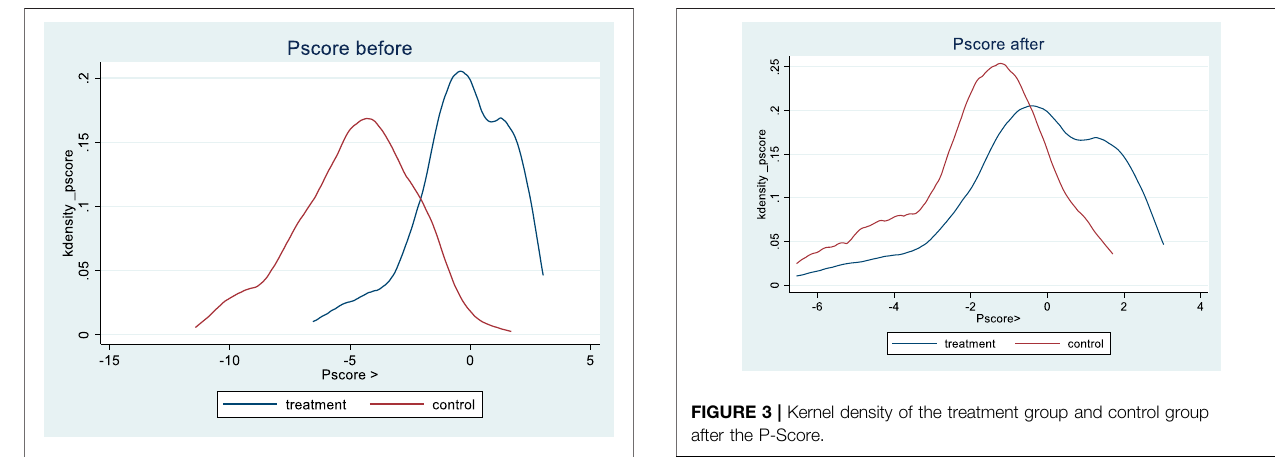
FIGURE 2 | Kernel density of the treatment group and control group before the P-Score.